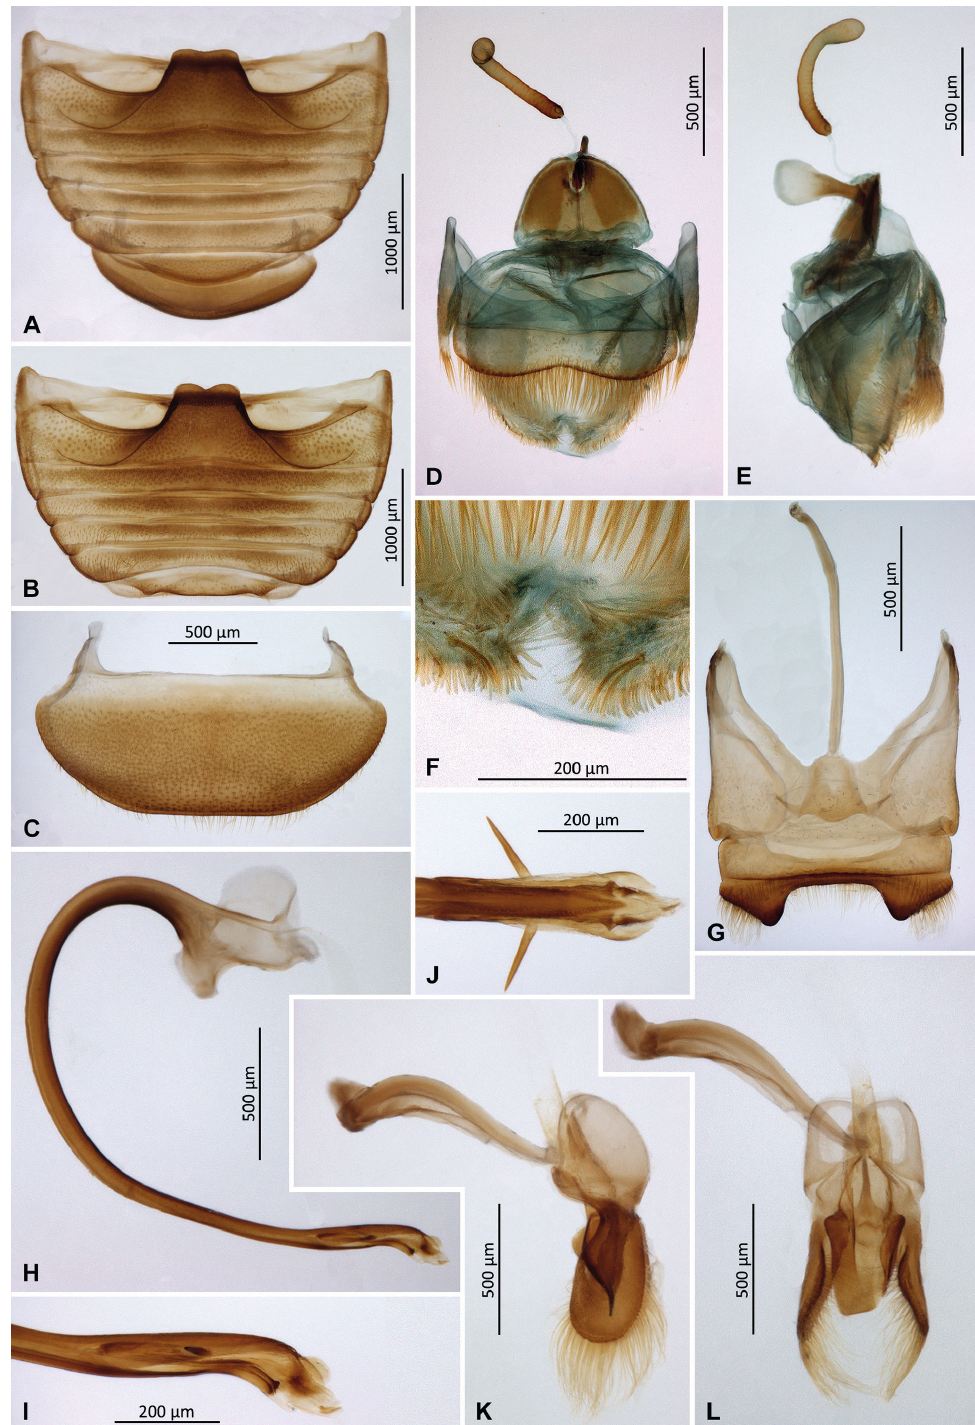
Fig. 2. Cyrea mcclarini sp. nov. A . Paratype (MIZ), ♀, abdomen. B . Holotype (MNHW), ♂, abdomen. C . Holotype (MNHW), ♂, tergite VIII. D . Paratype (MIZ), ♀, genitalia, ventral view. E . Paratype (MIZ), ♀, genitalia, lateral view. F . Paratype (MIZ), coxites apices, ventral view. G . Holotype (MNHW), ♂, segments IX and X, dorsal. H . Holotype (MNHW), penis, lateral. I . Holotype (MNHW), penis tip, lateral. J . Holotype (MNHW), penis tip, inner. K . Holotype (MNHW), tegmen, lateral view. L . Holotype (MNHW), tegmen, inner